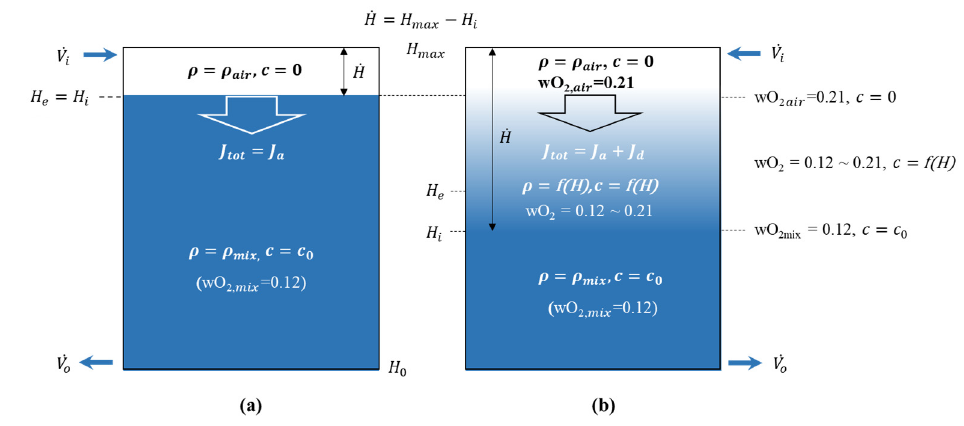
Figure 3. Schematic diagram of the z-direction diffusion flux with and without species diffusion: ( a ) Without species diffusion; ( b ) with species diffusion.